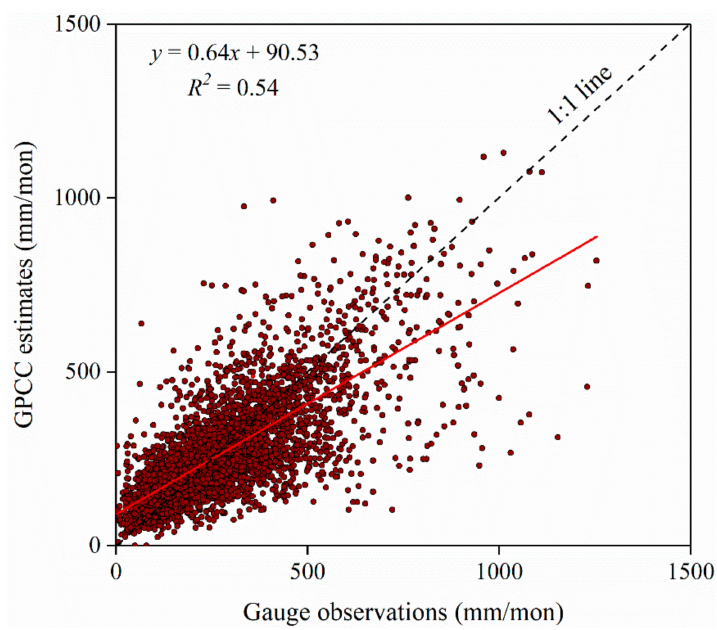
Figure 2. Scatterplot of monthly precipitation during June–September (JJAS) in 1998–2015 from gauge observations against the Global Precipitation Climatology Centre (GPCC)